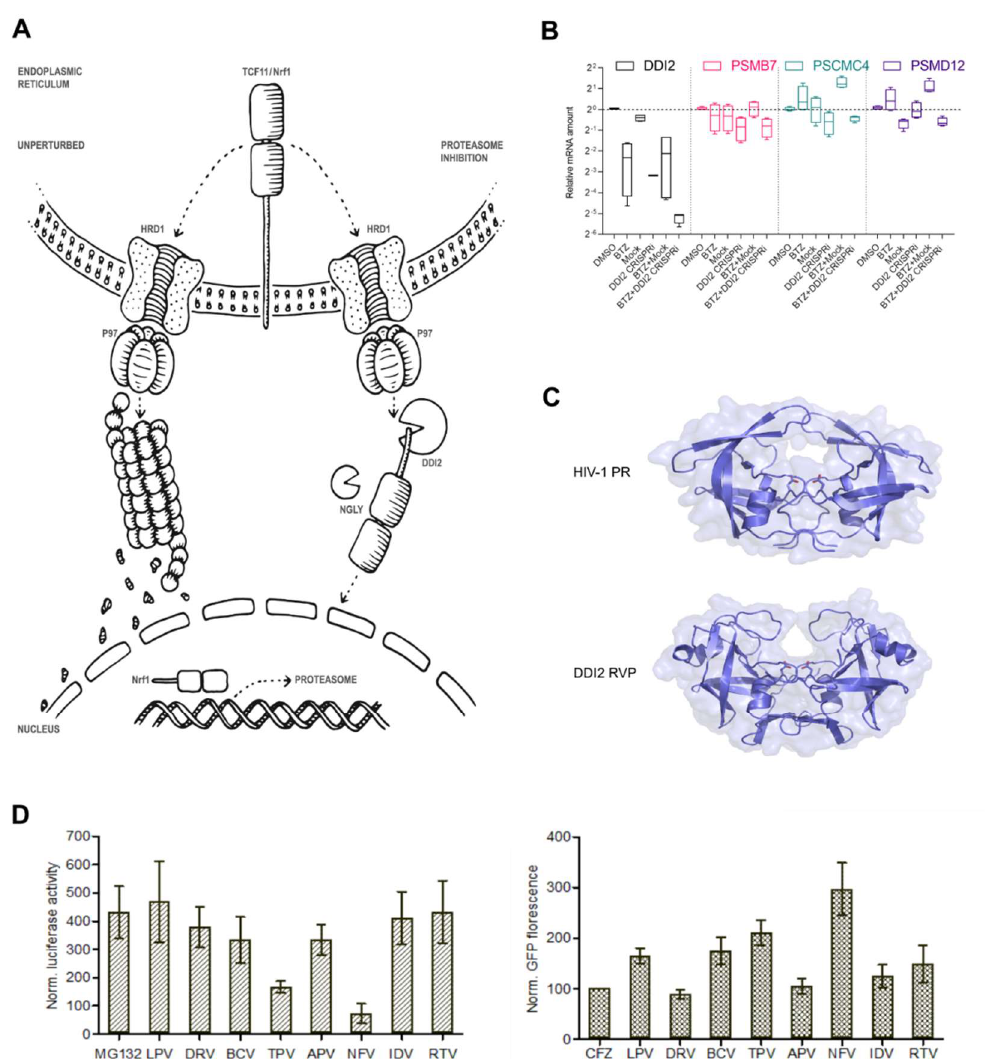
Figure 1. DDI2 is required for efficient proteasome re-synthesis in MM cells. ( A ) Current model of DDI2 function in the regulation of TCF11/Nrf1 transcriptional activity. Under normal conditions, TCF11/Nrf1 resides in the ER membrane, undergoes ubiquitination by HRD1, and is retrotranslocated by VCP / p97 to the cytosol, where it is degraded by the proteasome. When proteasome function is impaired, TCF11 / Nrf1 is deglycosylated by N-glycanase 1 (NGLY1), extracted from the ER